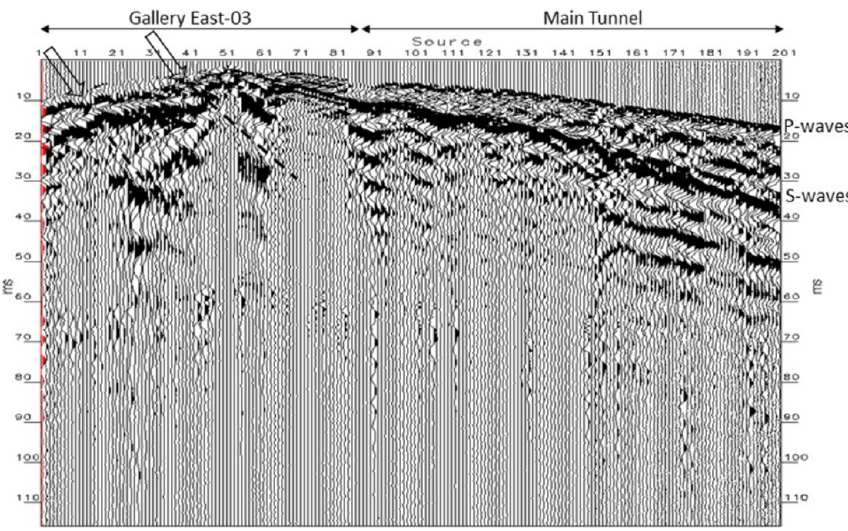
Figure 5. Raw data example of seismograms recorded by the radial component in BH14. Arrows mark later P-wave arrival times which indicates the location of fault core and possible fractured zones within the damaged zone along in gallery